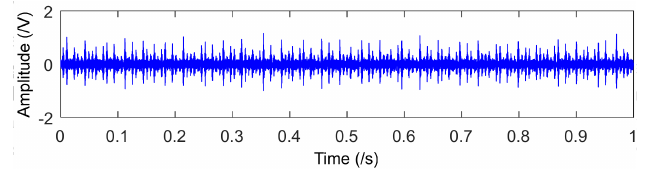
Figure 17. The time waveform after noise reduction.